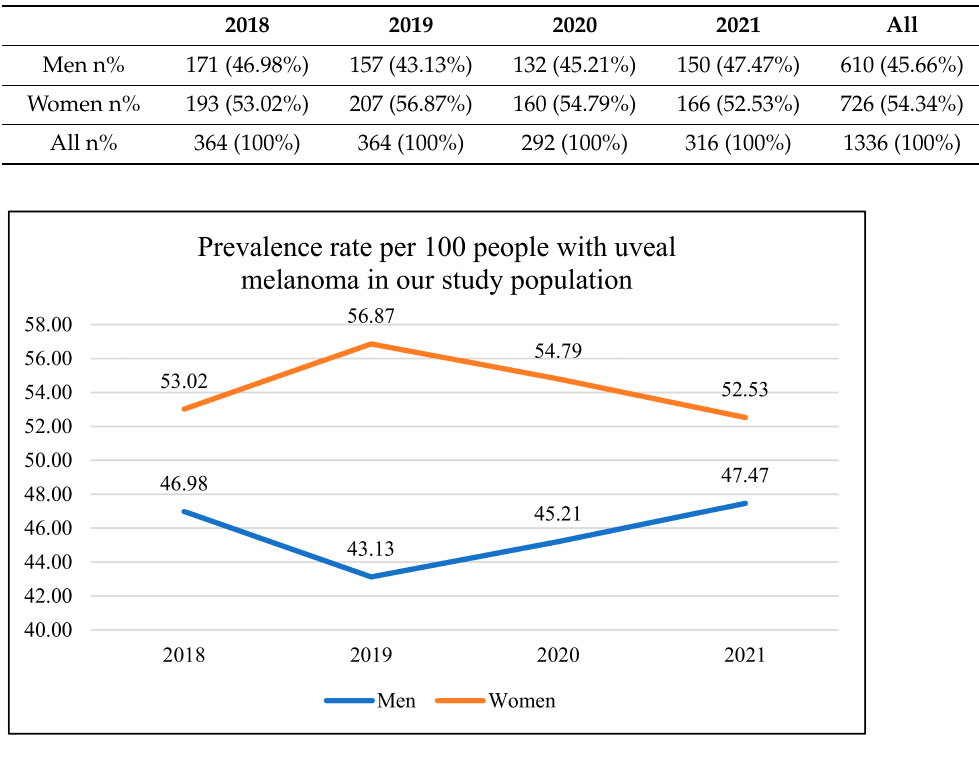
Figure 1. Sex differences in prevalence rate per 100 people included in the present study (with uveal melanoma) in the national referral center in Poland between 2018 and